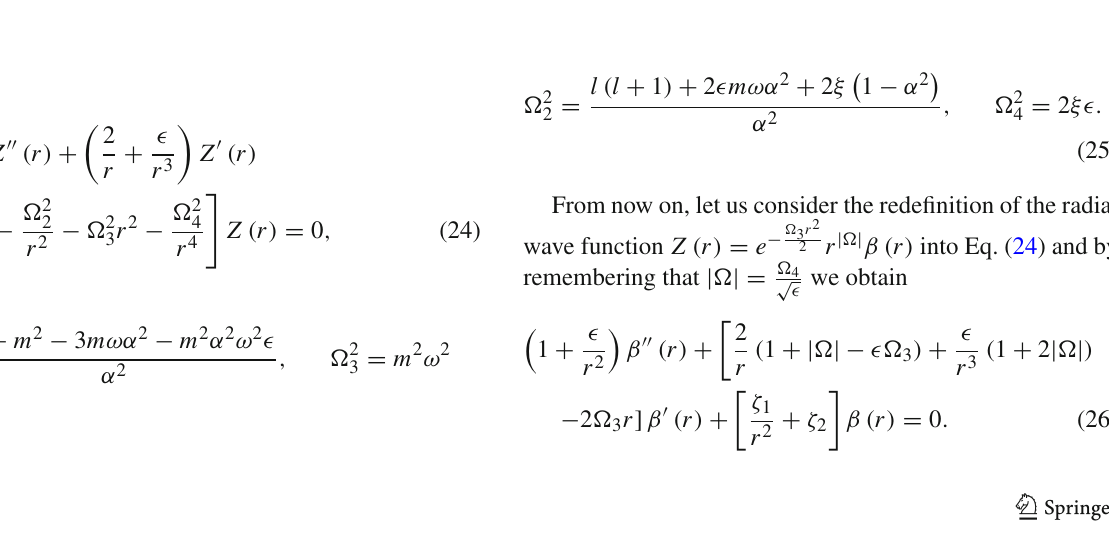
| as a function of m 2 (cid:4) . Fig. 2 In both figures we are visualizing | E l , 1 fixed ω/ m = l = 1 and also did α = 0 . 2. The dotted lines indicate the m negative energy values. In the figure on the right, we carry out the same In the figure on the left, we have the continuous blue curve that repre- process now by varying the parameter α = 0 . sents the positive sign inside the square root Eq. (18) and the red curve continues the negative sign also from inside the root of Eq. (18). We